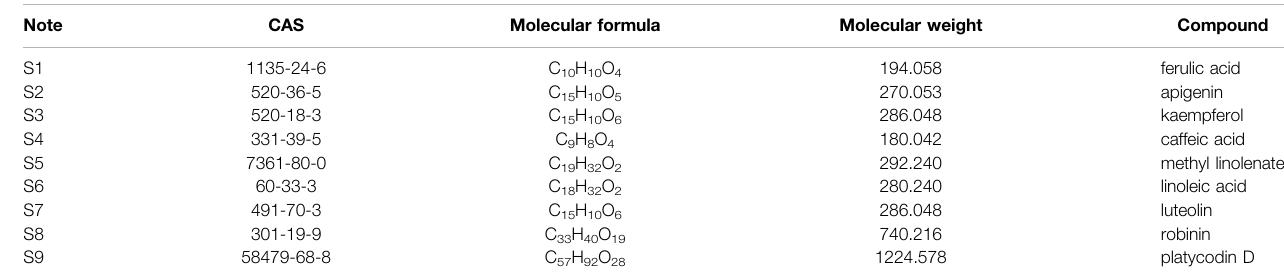
TABLE 2 | Information on the 9 active ingredients in Platycodon grandi fl orum.